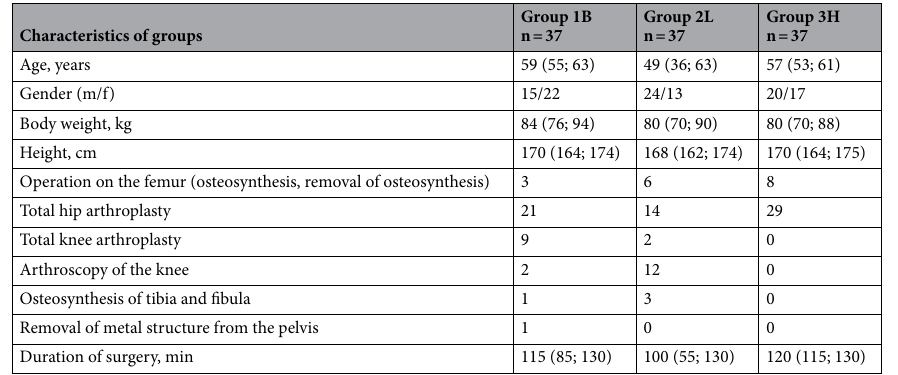
Table 1. Characteristics of the study groups of patients. Values are median (1Q, 3Q). Group 1B—0.5% bupivacaine, Group 2L—0.5% levobupivacaine, Group 3H—0.5% hyperbaric bupivacaine. Gender (m/f)— male/female.